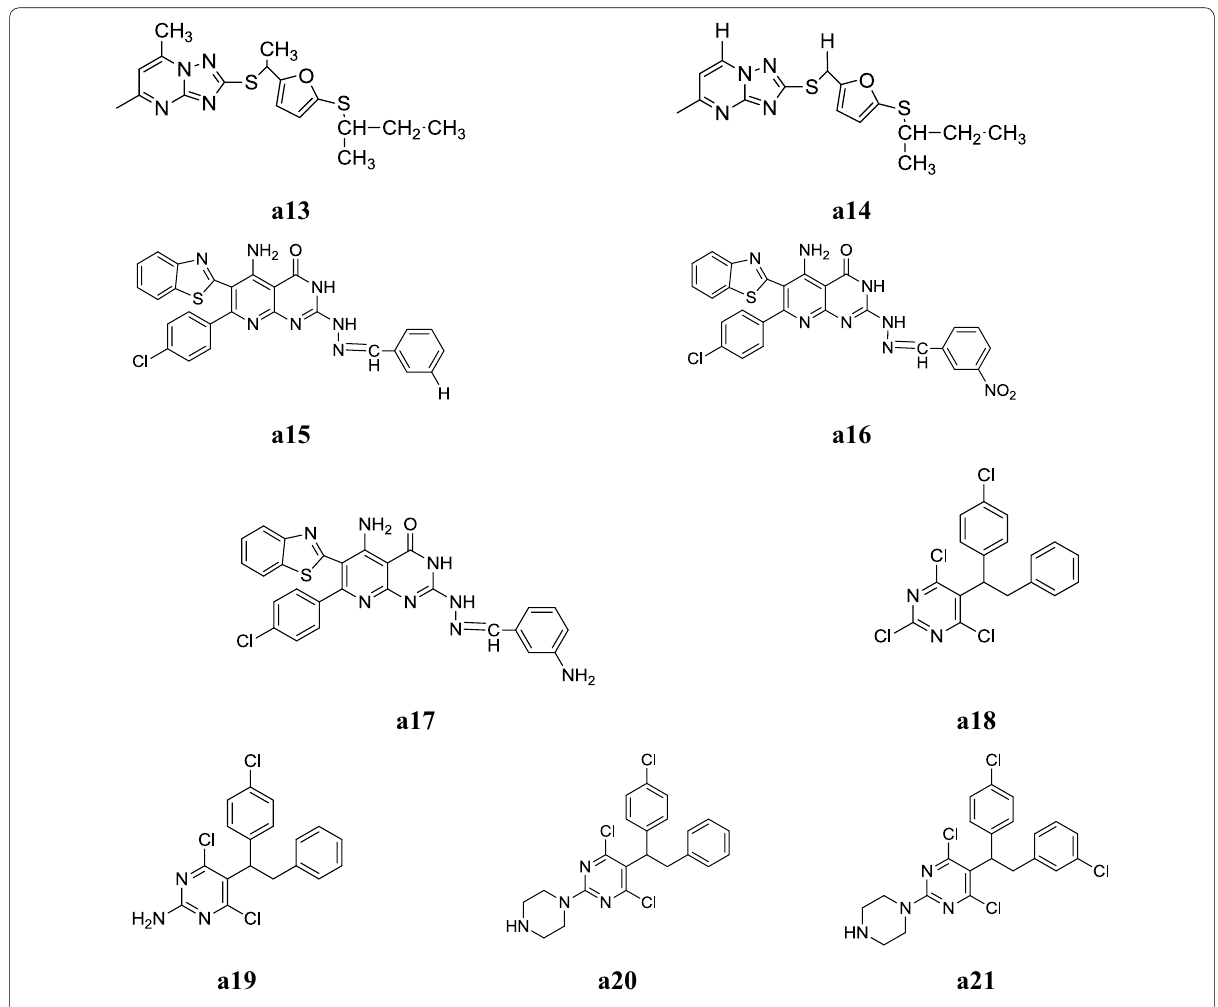
Fig. 3 Chemical structure of the most active antimicrobial pyrimidine derivatives ( a13 – a21